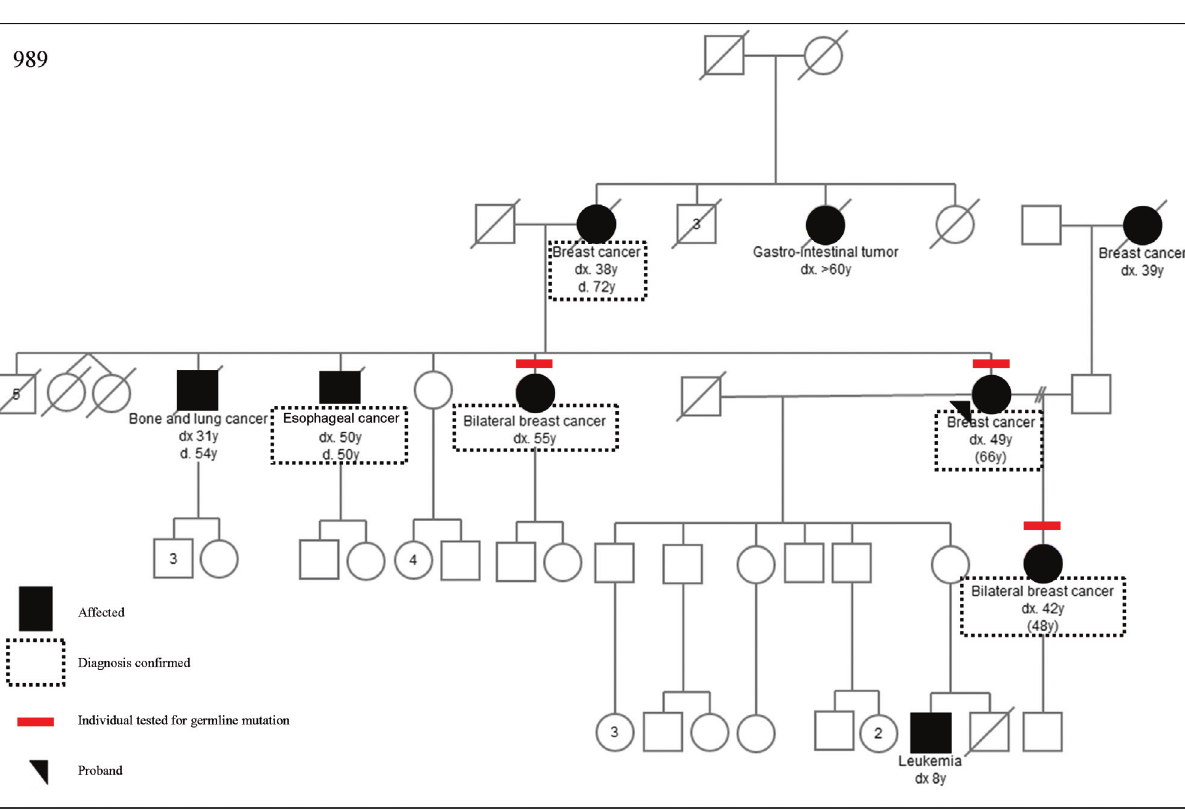
Figure 1 - Pedigree of a family with p.E3002K mutation in BRCA2